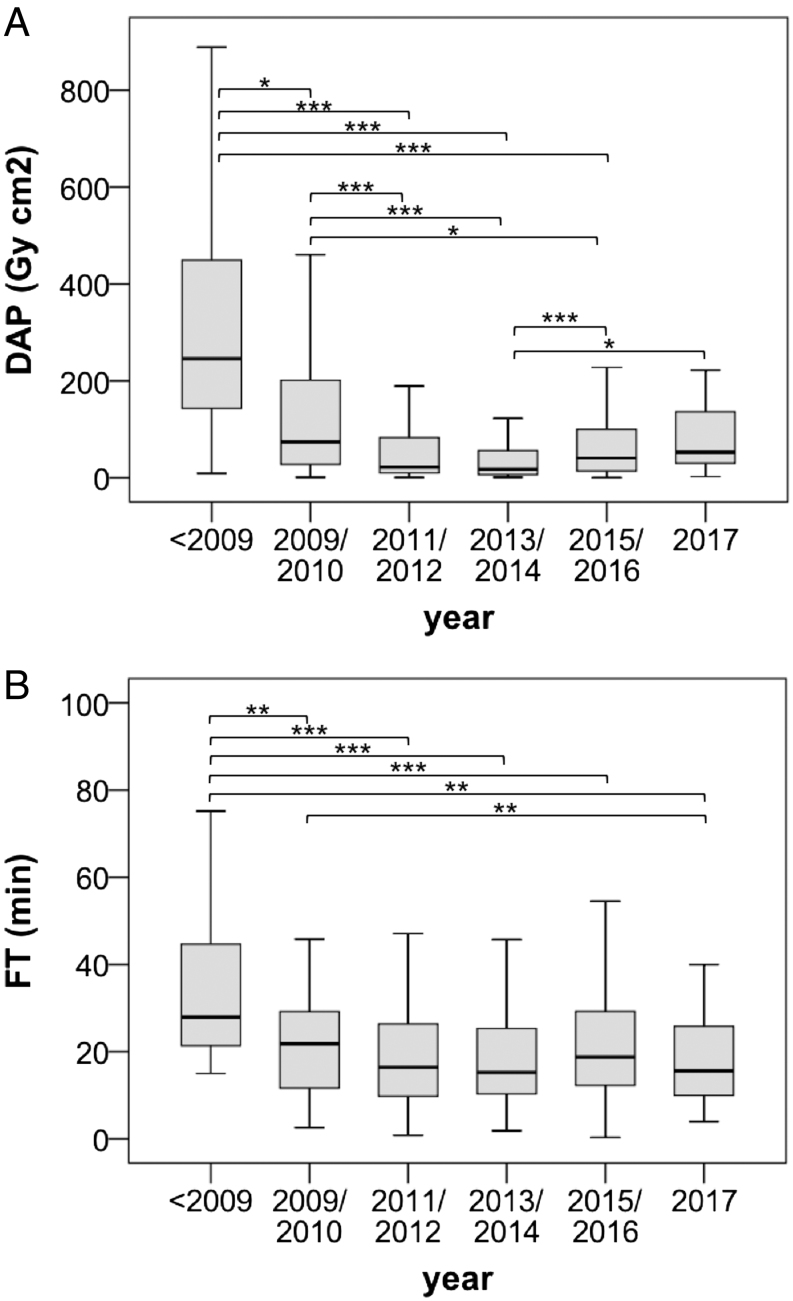
Dose area product ((A), DAP, Gy*cm²) and fluoroscopy time ((B), FT, min) across different years. <2009: n = 39, DAP 246 (9.2–888), FT 28 (15–99); 2009/2010: n = 75, DAP 74 (1.1–705), FT 22 (2.6–116); 2011/2012: n = 119, DAP 22 (0.8–789), FT 16 (0.8–104); 2013/2014: n = 177, DAP 18 (1.2–1167), FT 15 (1.9–103); 2015/2016: n = 212, DAP 41 (0.3–3181), FT 19 (0.3–184); 2017: n = 24, DAP 53 (2.5–222), FT 16 (4.0–63). *P ≤ 0.05, **P ≤ 0.01, ***P ≤ 0.001.